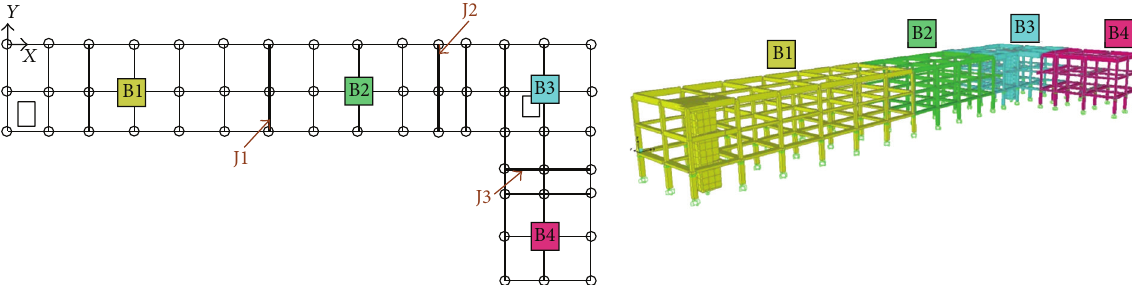
Figure 2: Numbering of the blocks (B1–B4) constituting the multiple building and relevant separation joints (J1–J3).